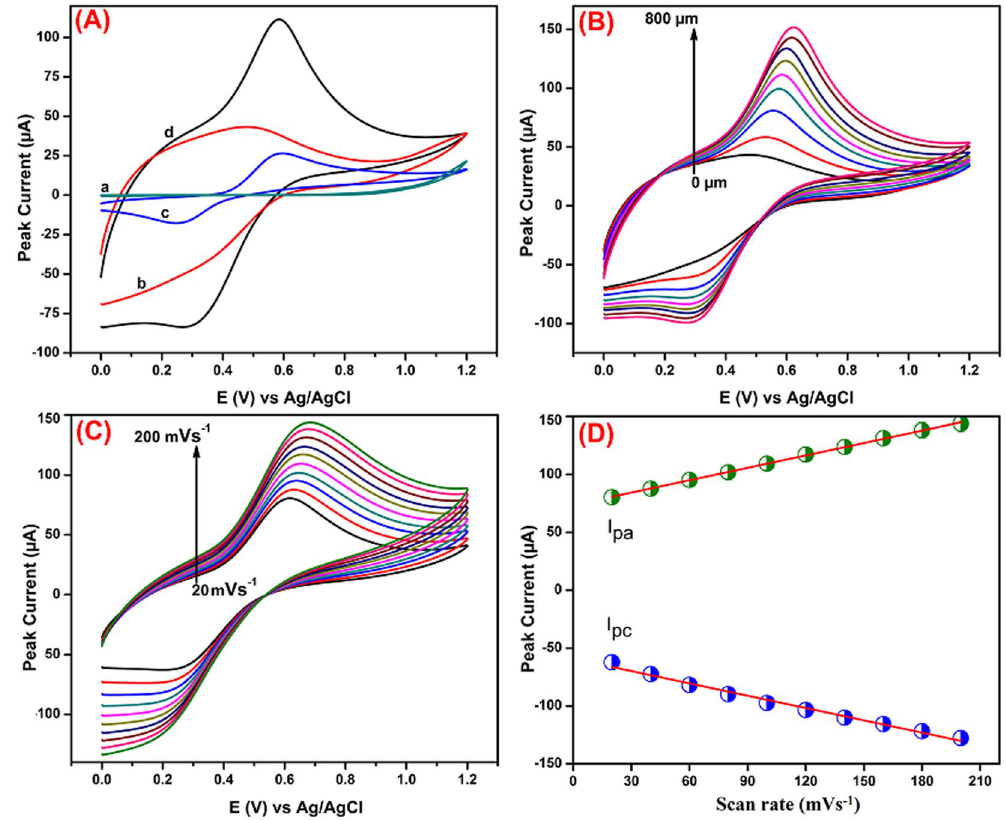
Figure 7. CVs performance of CA at different modified electrodes bare GCE (a) SrV 2 O 6 /GCE (b) in the presence (c,d) and absence (a,b) of 400 µ M CA containing 0.1 M KCl at a scan rate 50 mVs − 1 ( A ). CVs performance of CA for various concentrations from 0 to 800 µ M ( B ). Different scan rates ranging from 20–200 mVs − 1 , 400 µ M CA using SrV 2 O 6 /GCE in the 0.1 M KCl ( C ). The relation between the peak current vs . scan rate ( D ).